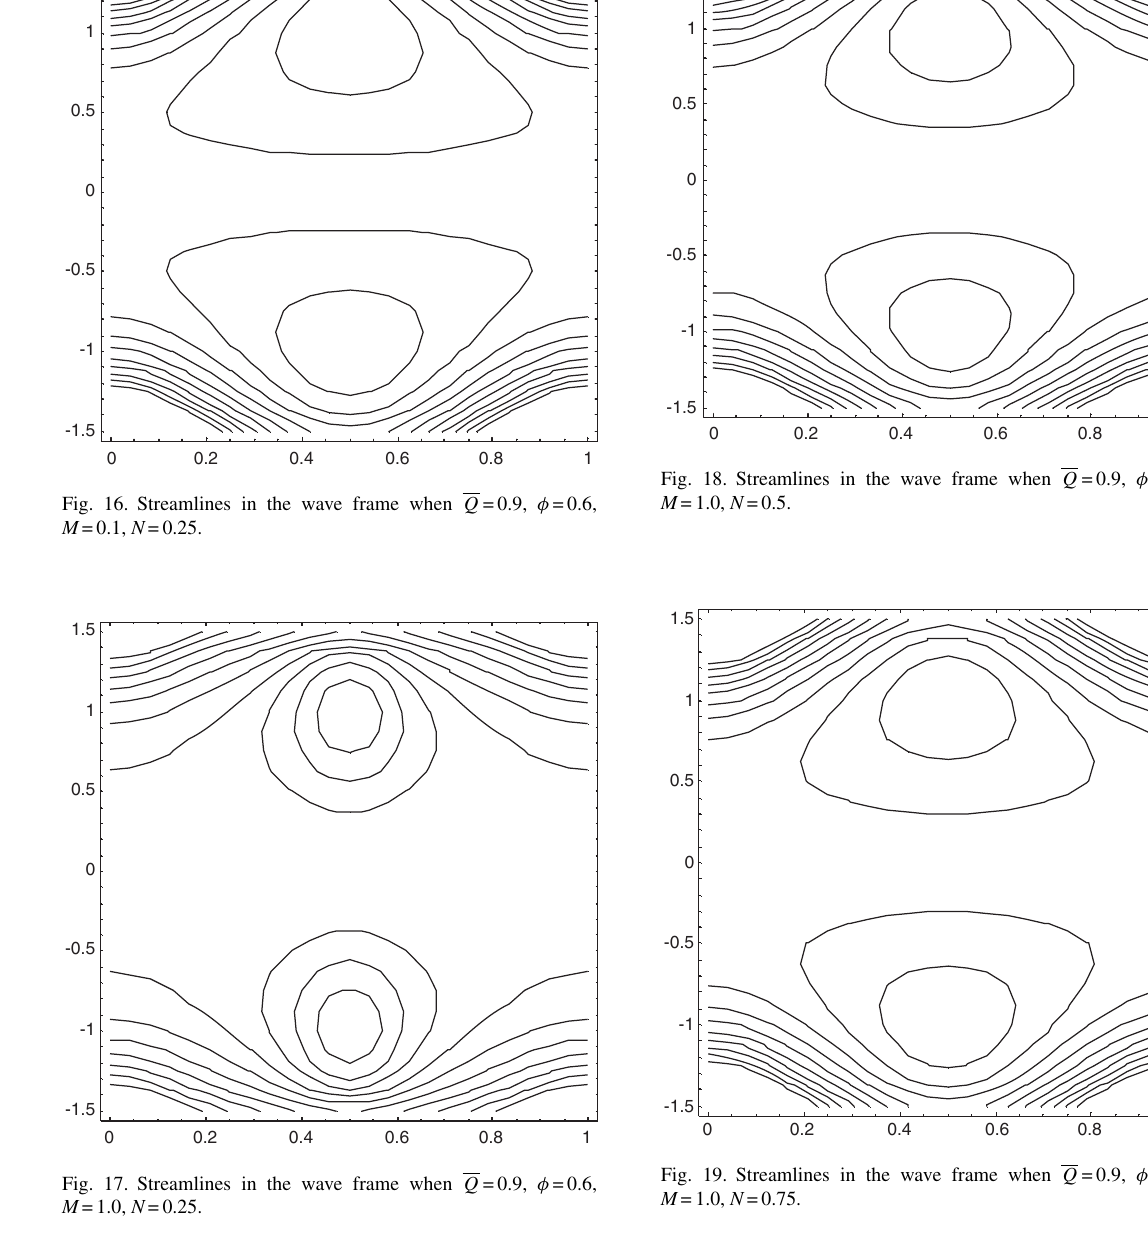
try to examine this for arbitrary flow rates by not caring whether the flow rates and occlusions are very high or not which are essential for trapping. Probably for this reason, they are inconclusive about the influence of M on